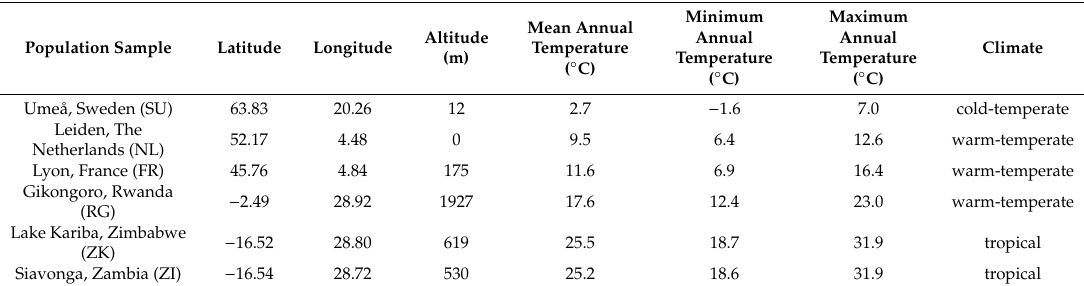
Table 1. Population